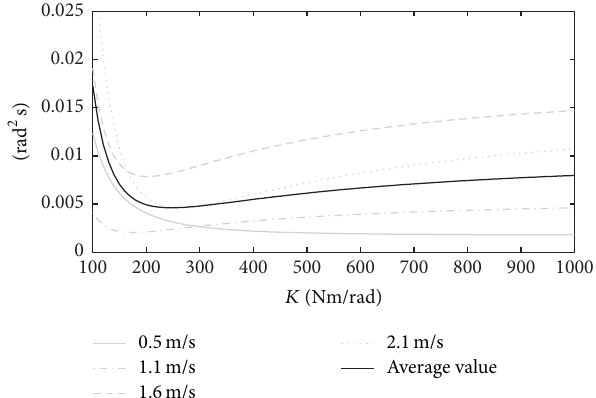
Figure 6: Kinematic similarity ( Ψ ) as a function of series stiffness averaged across walking speeds for subject weight of 75 kg. The minimum value of Ψ is kept approximately at the series stiffness value of 250